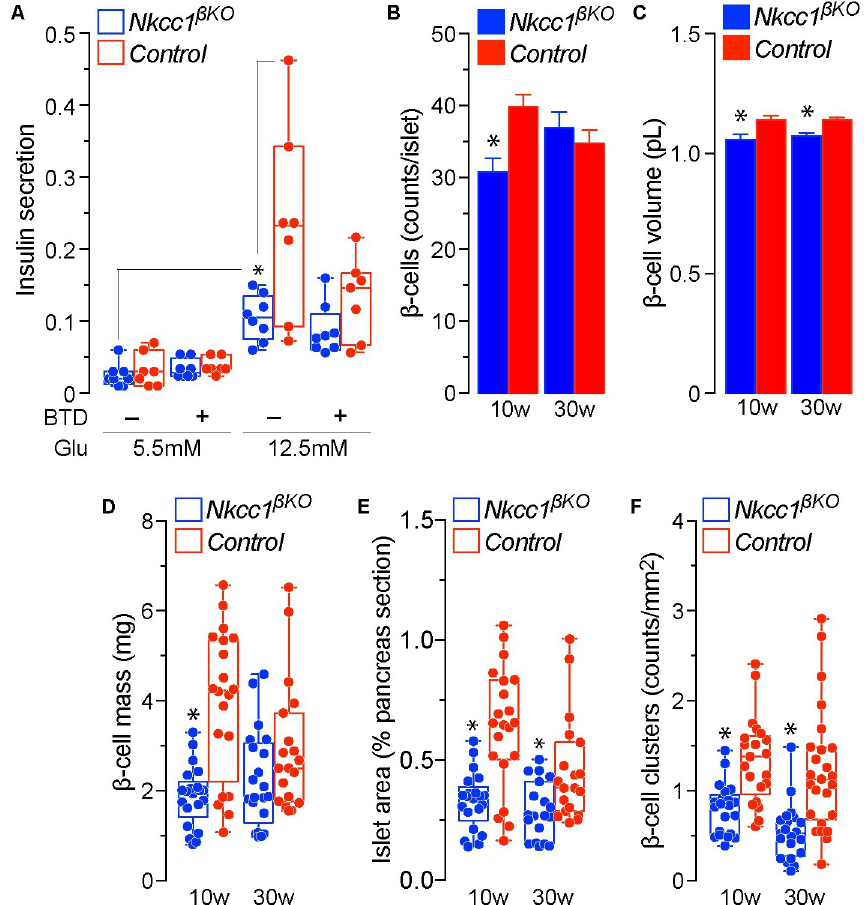
Fig 2. Loss of Nkcc1 in β -cells reduces islet insulin secretion and β -cell mass. A . Insulin secretory responses to low (5.5mM) and high (12.5mM) glucose of islets from 22w old Nkcc1 β KO and control mice ( Nkcc1 lox/lox ) in the presence of vehicle (DMSO) or 10 μ M bumetanide (BTD), as indicated. Results are expressed as the mean ± SEM of insulin secreted relative to total islet insulin content ( n = 7–8, � p < 0.05). B-F . Morphometry analysis performed on pancreas sections from Nkcc1 β KO and control mice ( Nkcc1 lox/lox ) at the indicated ages and immunolabeled against insulin. Shown are the number of β -cells per islet (B), mean β -cell volume (C, pL), β -cell mass (D, mg), islet area (E, % pancreas section) and the number of β -cell clusters (representing � 5 β -cells/cluster) per mm 2 of pancreas tissue section (F). The data in B-C represents the mean ± SEM corresponding to > 700 individual islets identified in 19–21 tissue sections obtained from male mice ( n = 3) of the indicated genotypes and ages. Each point in D-F represents the mean values per single tissue section ( � p < 0.05). Nkcc1 β KO mice. However, expression levels of Insr were found reduced only in younger (10- 20w) Nkcc1 β KO relative to controls and did not differ at 30 weeks of age in Nkcc1 β KO mice (Fig 3C). Interestingly, G6Pc protein expression relative to β -actin remained unchanged in Nkcc1 β KO mice suggesting intact endogenous glucose production. However, as shown in Fig 3D, glucose responses to exogenous alanine increased in 30w old Nkcc1 β KO mice, thus suggest- ing age-dependent deterioration in the control of hepatic de novo gluconeogenesis. Excess weight, increased fat mass and adipocyte hypertrophy in Nkcc1 β KO mice Ad libitum chow-fed Nkcc1 β KO male mice significantly increased their body weight (BW) as they became older (Fig 4A), and this was not attributed to increased daily food intake (S4A